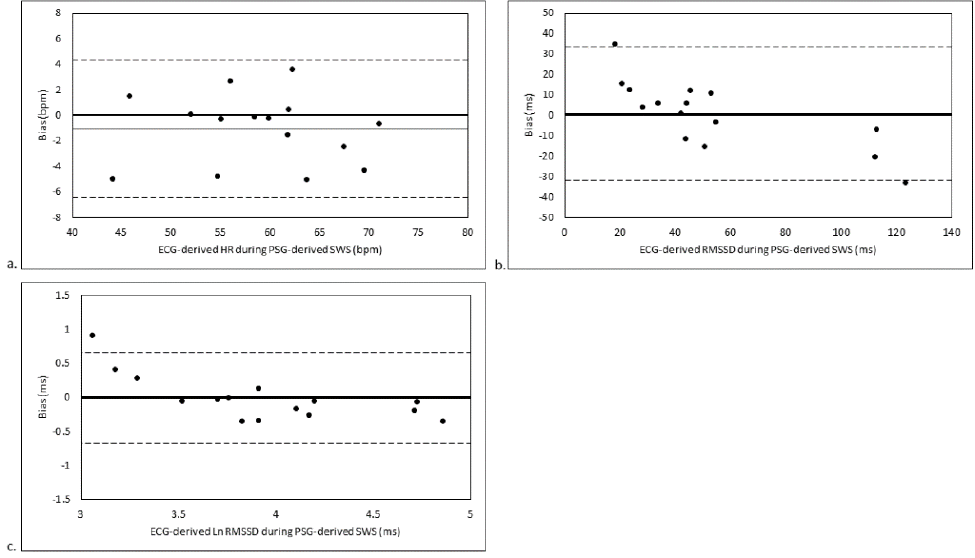
Figure 2. Agreement between ( a ) ECG-derived HR during PSG-derived SWS and WHOOP-derived HR during WHOOP-derived SWS, ( b ) ECG-derived RMSSD during PSG-derived SWS and WHOOP-derived RMSSD during WHOOP-derived SWS, and ( c ) ECG-derived Ln RMSSD during PSG-derived SWS and WHOOP-derived Ln RMSSD during WHOOP-derived SWS. Bias is calculated as WHOOP-derived variable during WHOOP-derived SWS minus ECG-derived variable during PSG-derived SWS. Thin continuous line represents mean bias. Dashed lines represent mean bias ± limits of agreement. bpm, beats per minute; ECG, electrocardiogram; HR, heart rate; Ln RMSSD, natural logarithm of the root mean square of successive BB interval differences; ms, milliseconds; PSG, polysomnography; RMSSD, root mean square of successive BB interval differences; SWS, slow-wave sleep.